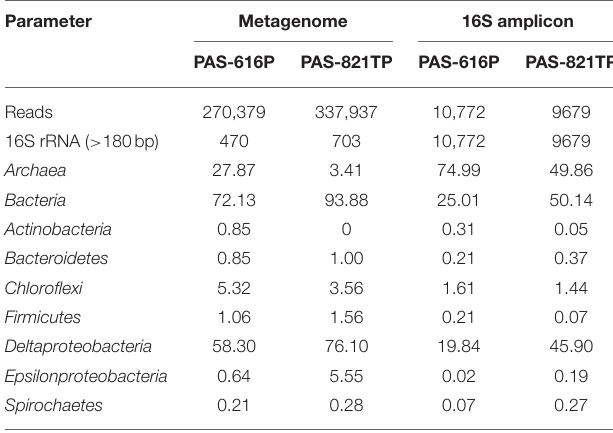
( Table 3 ). The phylogenetic association of hydL genes was similar with most ( Table 3 : 64 and 51%) belonging to the Firmicutes , consistent with a function in H 2 production in both metagenomes. In contrast, archaeal hynL genes